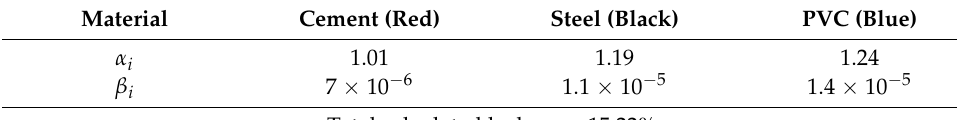
Table 2. Results for α i and β i (using field data described in Figure